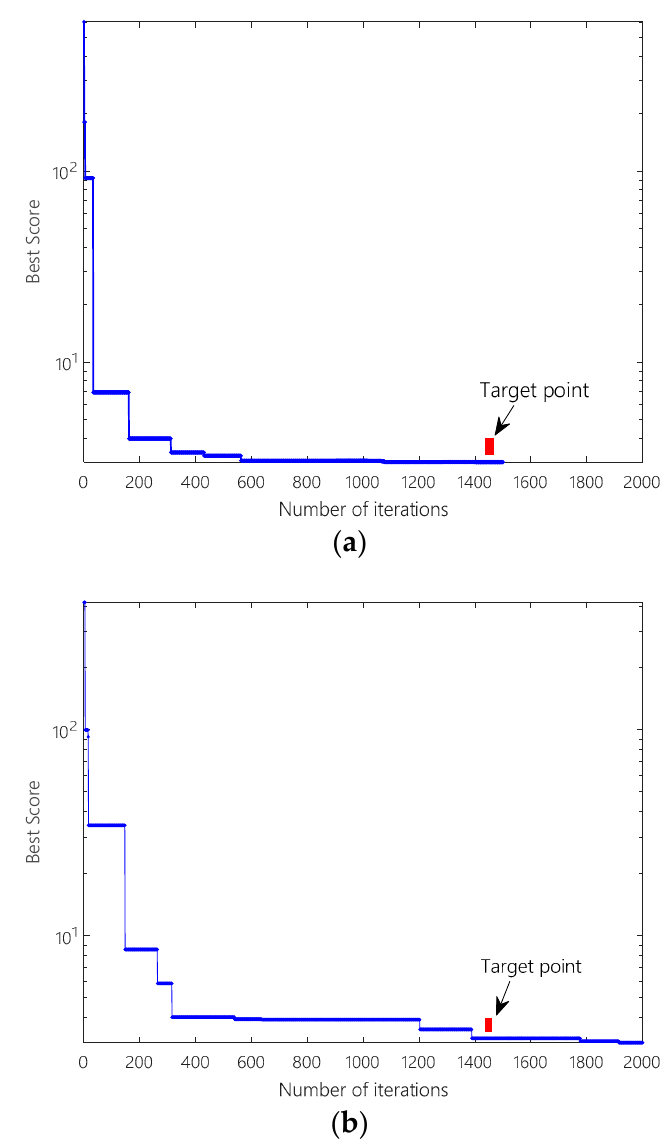
Figure 6. Convergence speed comparison for ( a ) PSO and ( b ) SA with eight agents.